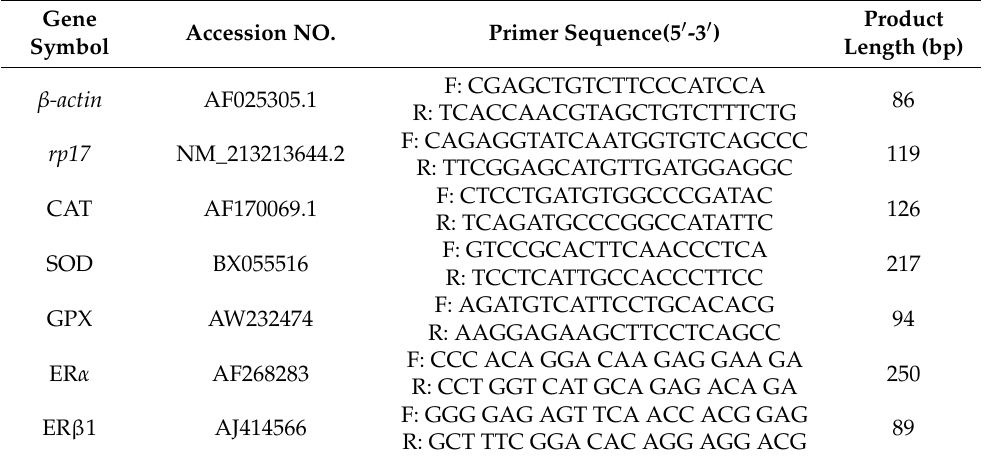
Table 4. Primer sequences of candidate reference